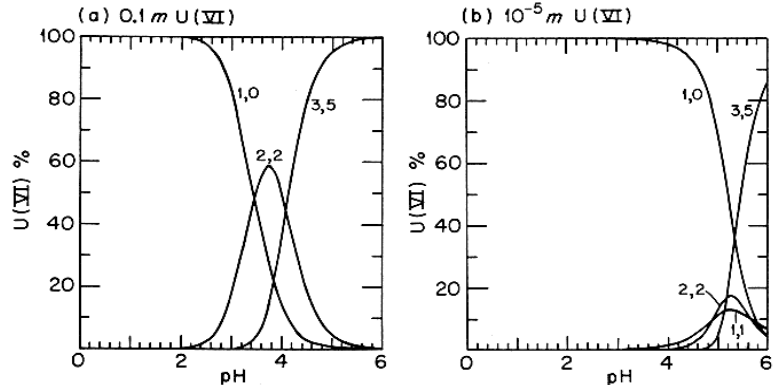
Fig. 11. Distribution of uranium hydrolysis products (1, 0): UO 22+ ; (2, 2): (UO